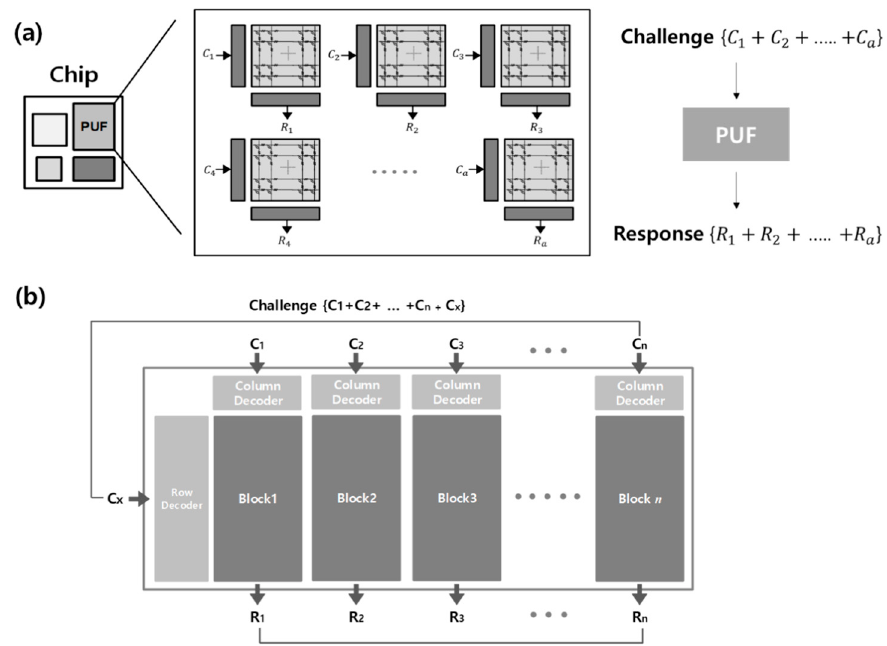
Figure 3. ( a ) A concept of the bank design for a PUF; and ( b ) a schematic diagram for the practical implementation of the bank design .